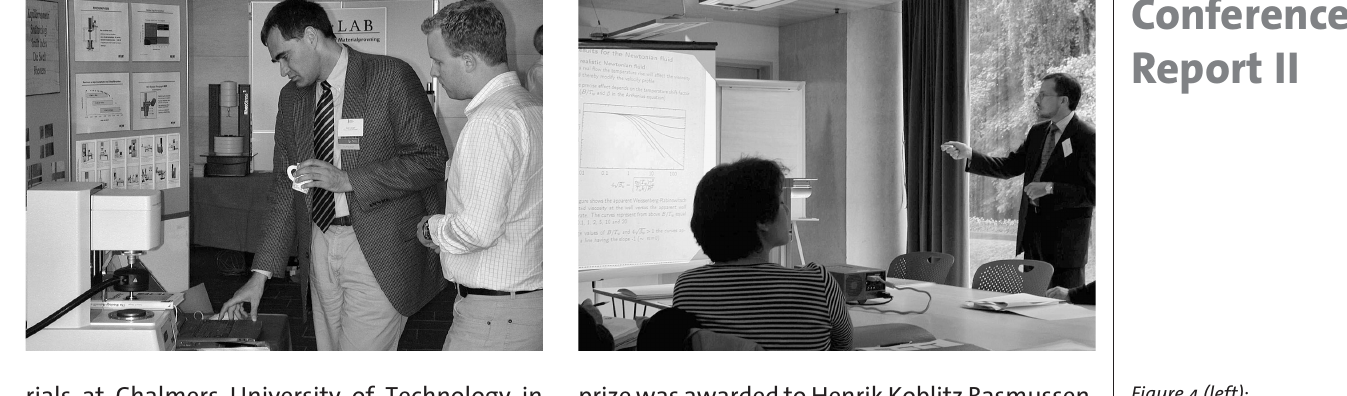
Figure 4 (left): from left to right Jörg Läuger, Gustav Upmark at exhibition Figure 5 (right): Peter Szabo lecturing